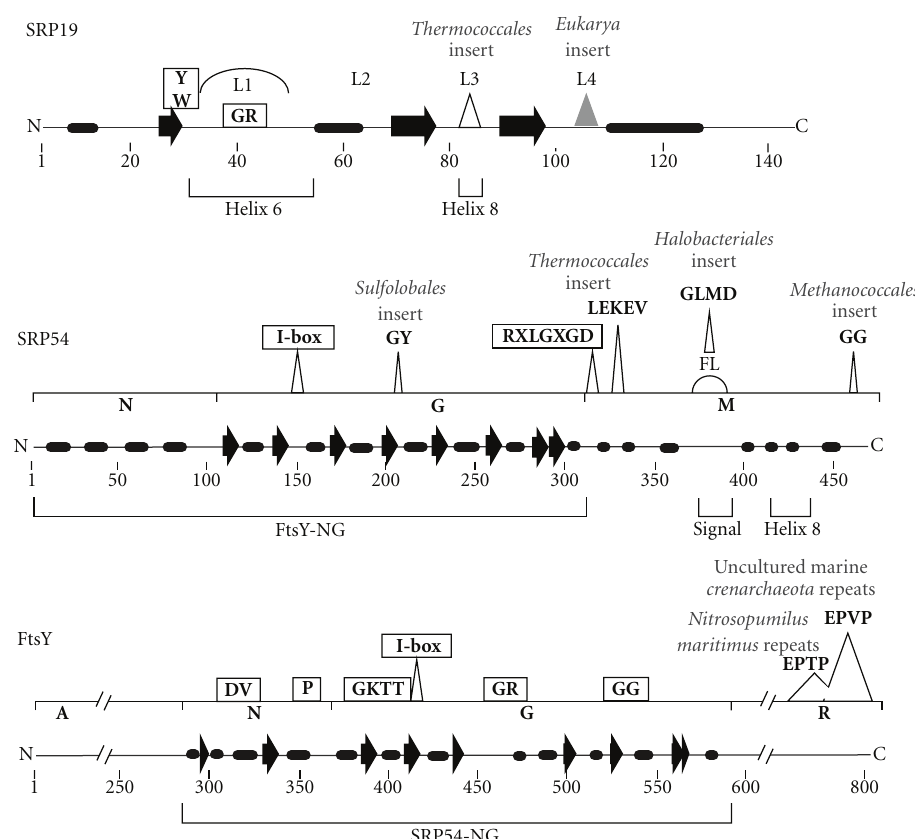
Figure 3: Features of SRP19 (top), SRP54 (center) and the FtsY SRP receptor (bottom). Indicated are the N- and C-termini. Helices are shown as cylinders, beta-sheets as arrows, and some loops are labeled with an arch and the letter L. Invariant or highly conserved residues are shown boxed, and several amino acid residue inserts which are characteristic for the indicated taxonomic groups are shown as bold letters. Numbering is according to the column positions of each protein alignment accessible as listed in Supplementary Materials 2 and at the SRP database at http://rnp.uthct.edu/rnp/SRPDB/SRPDB.html). Regions and sites which interact with other SRP components or the signal sequence are marked with brackets below each